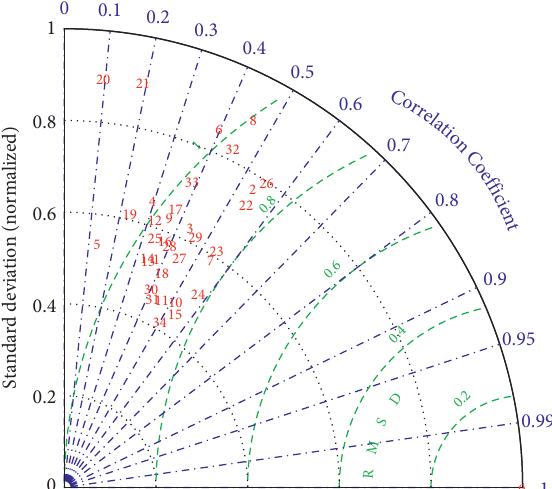
Figure 6: Taylor diagram for precipitation of 34 CMIP6 models. Historical model simulations and observations from 1961 to 2014 are used to calculate the statistics. The number 0 represents observation and models are indicated from 1 to 34 as that in Table 3.